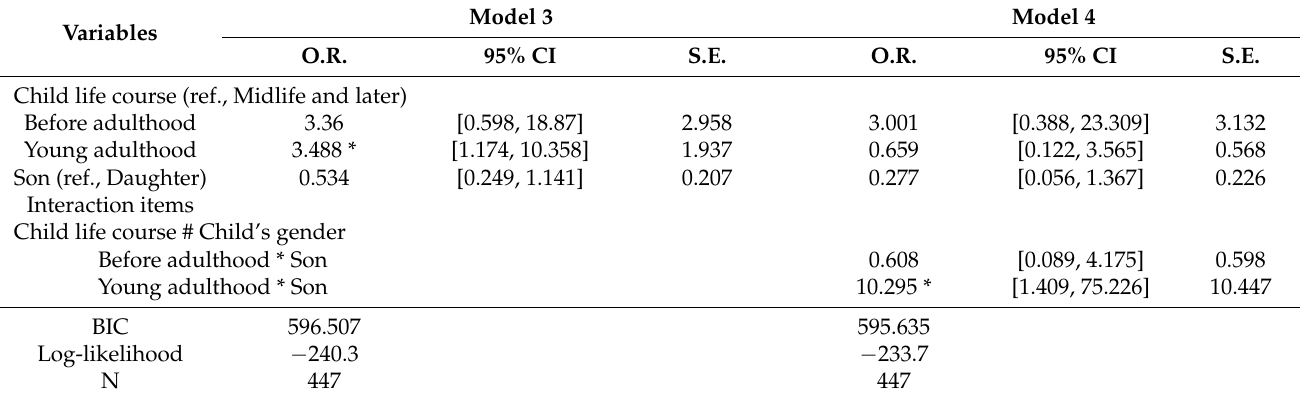
Table 3. Random-effects logistic regression models predicting parental depression by life course of deceased